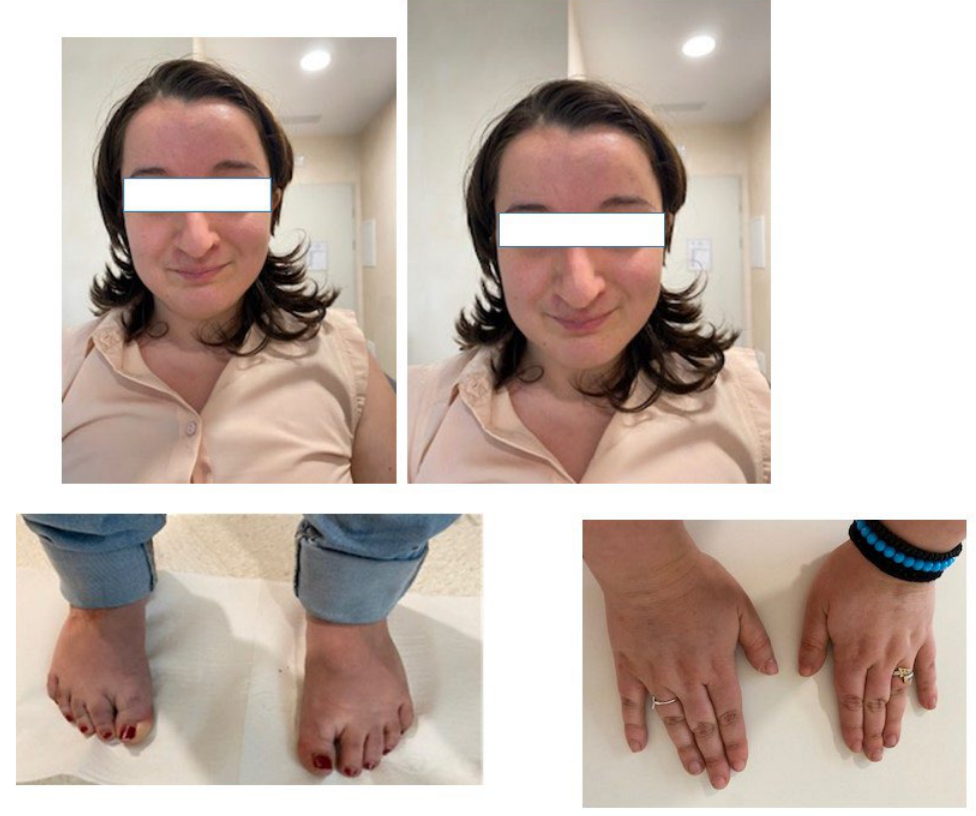
Figure 1. Clinical presentation of our patient.